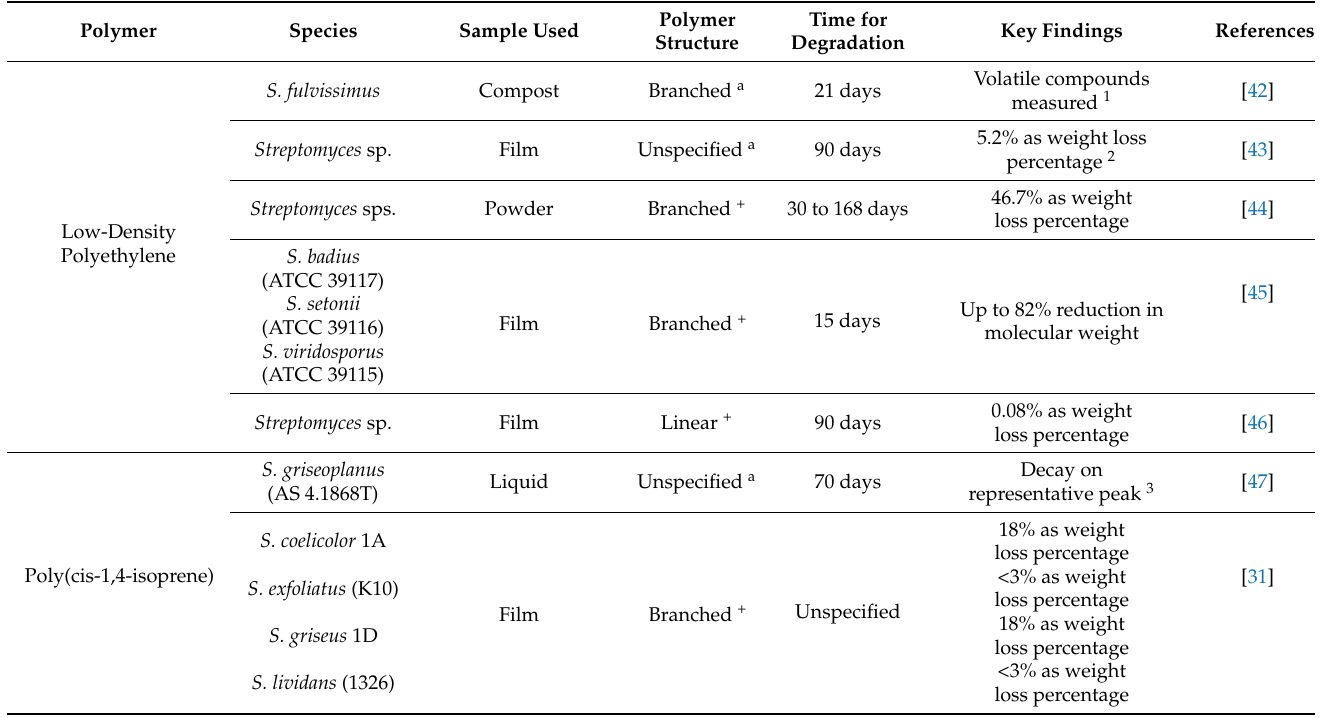
Table 1. The characteristics and general specifications of the polymers evaluated in the included